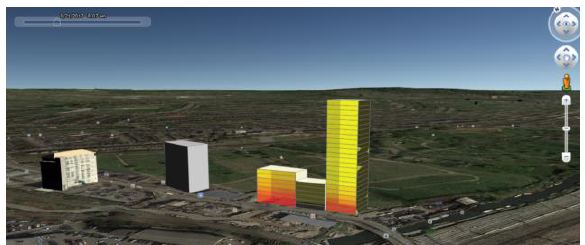
Figure 5 The noise model at 8.00 am as seen from the south- east side of the development.